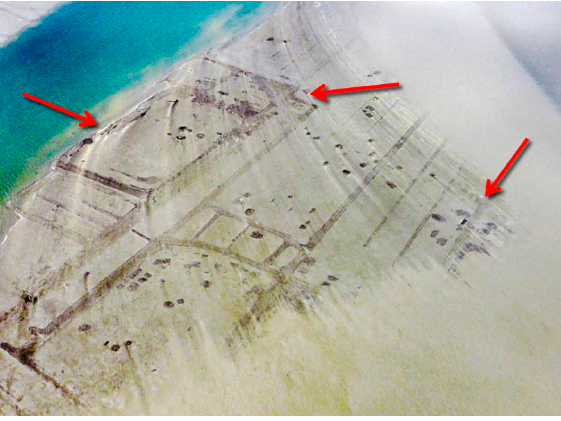
Figure 7. Aerial photograph of exposed intertidal flats north of Pellworm, taken in July 2009. Residuals of former settlements, close to a tidal creek (upper left), can be clearly seen. The arrows were included for easier comparison with the SAR images shown in Figure 8. Photograph: B. Hälterlein, LKN.